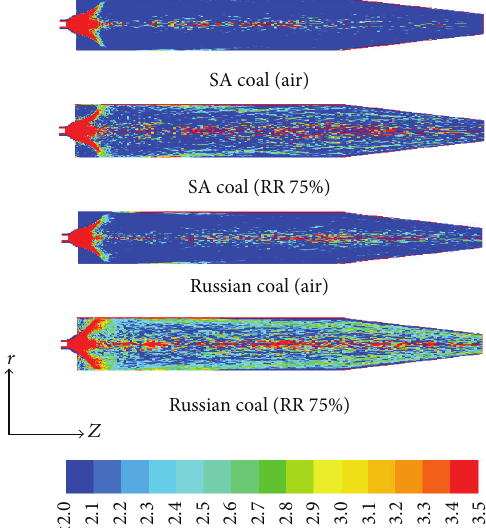
Figure 6: Contours of particle extinction coefficients ( 𝜎 𝑝 + 𝑘 𝑝 ) (in m −1 ) during the combustion of Russian and SA coal in air and in the oxy-75% RR